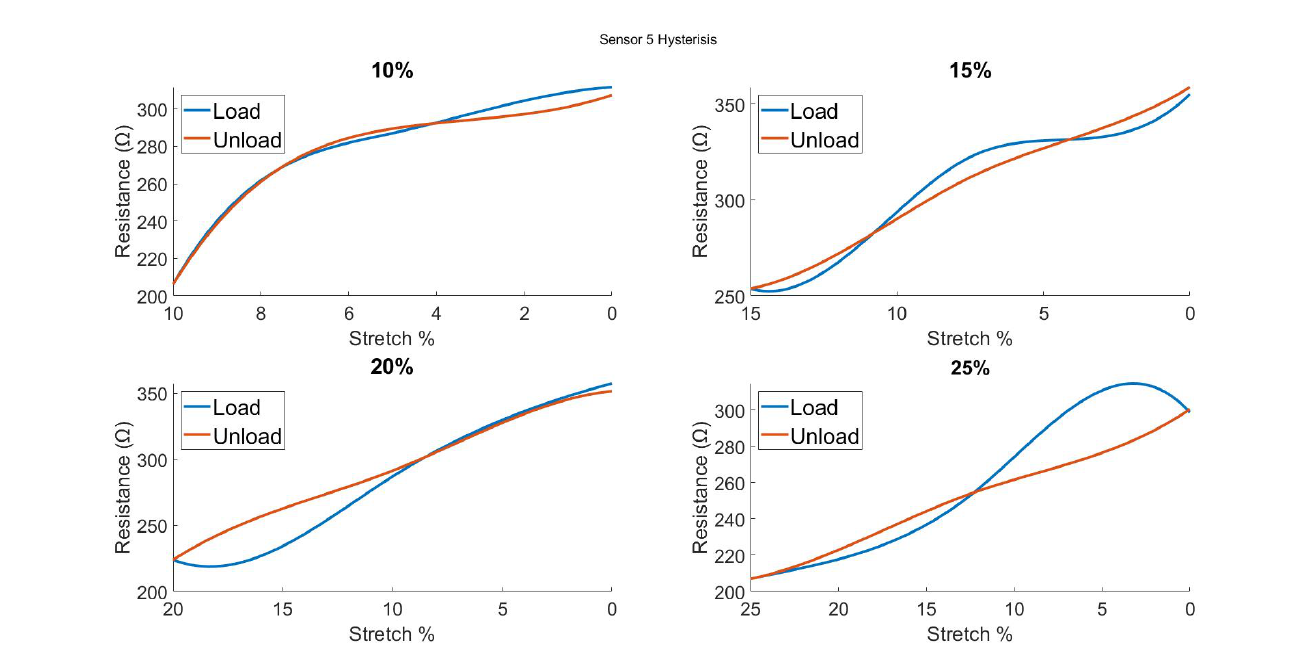
Figure A15. Hysteresis (sensor-5).